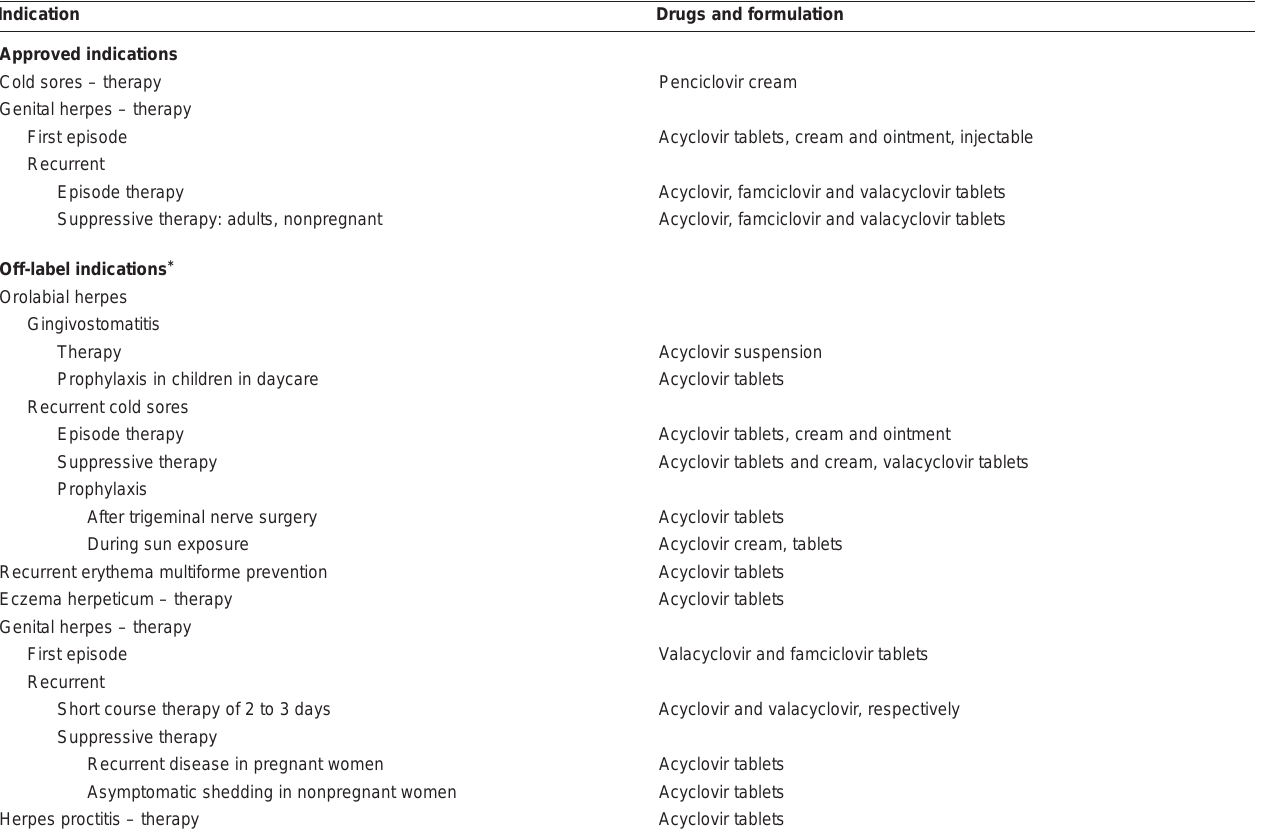
TABLE 1 Therapeutic Products Directorate (TPD) of Health Canada approved and off-label indications for oral and topical antiherpes drugs in Canada,